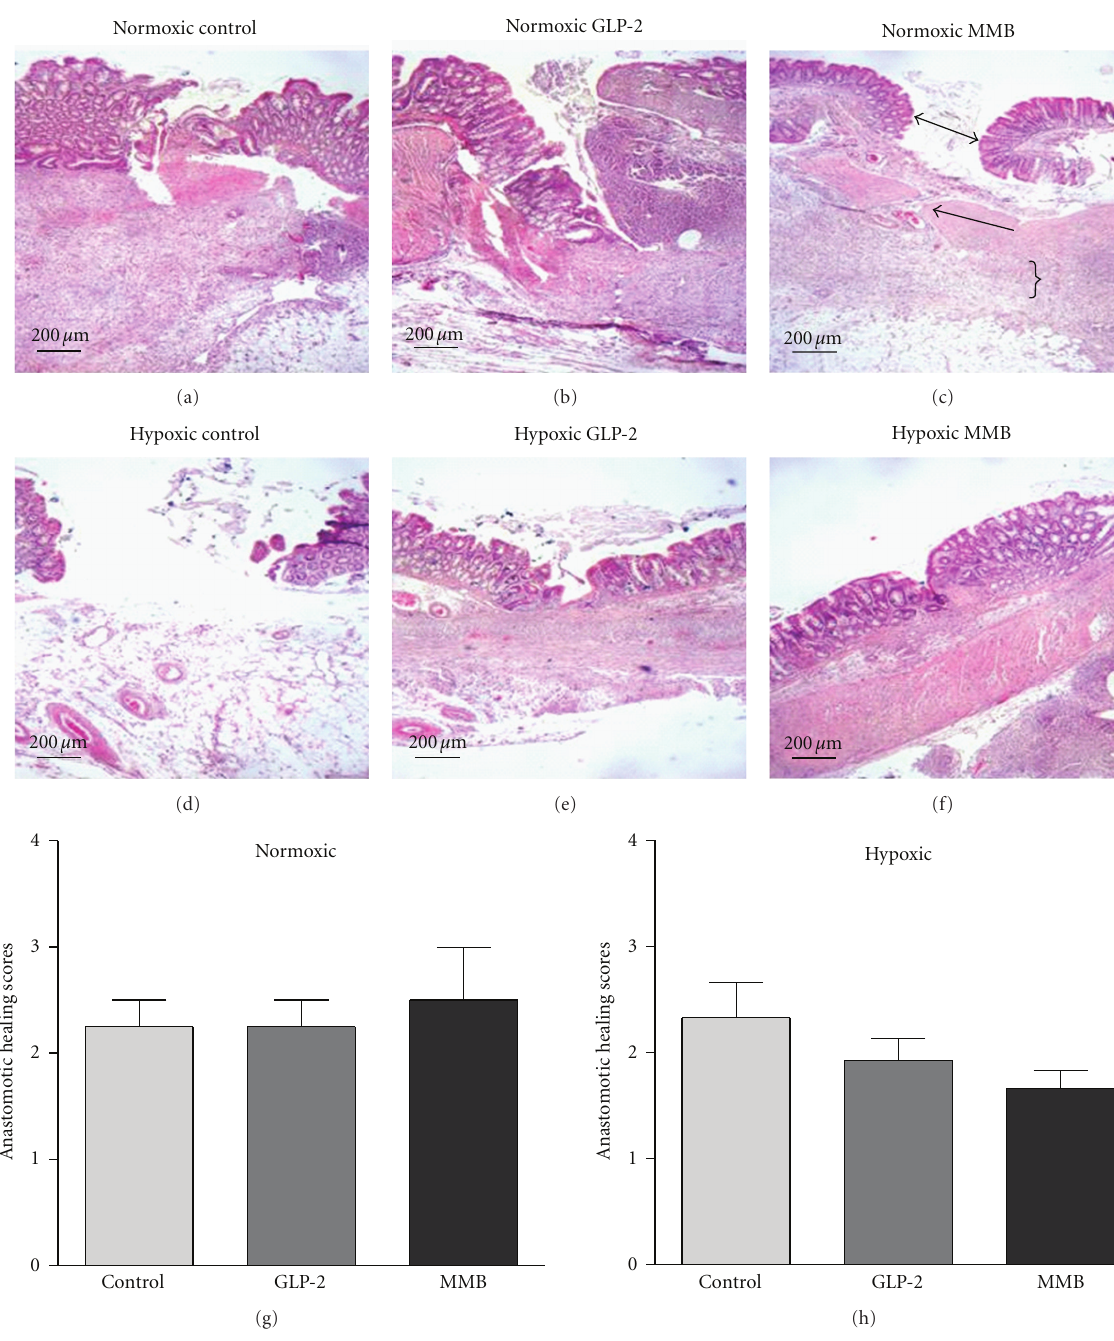
Figure 3: Histological sections of colonic anastomosis (H and E × 4) ( { indicates zone of inflammation, arrows; indicate zones of epithelial and muscular bridging } ). Anastomotic healing scores in normoxic and hypoxic animals: treated with GLP-2, GLP-2 mimetibody (MMB) and controls. Rating scale 0–9, with 0 indicating perfect healing [5]. data: mean ± SEM; n = 7 or more per